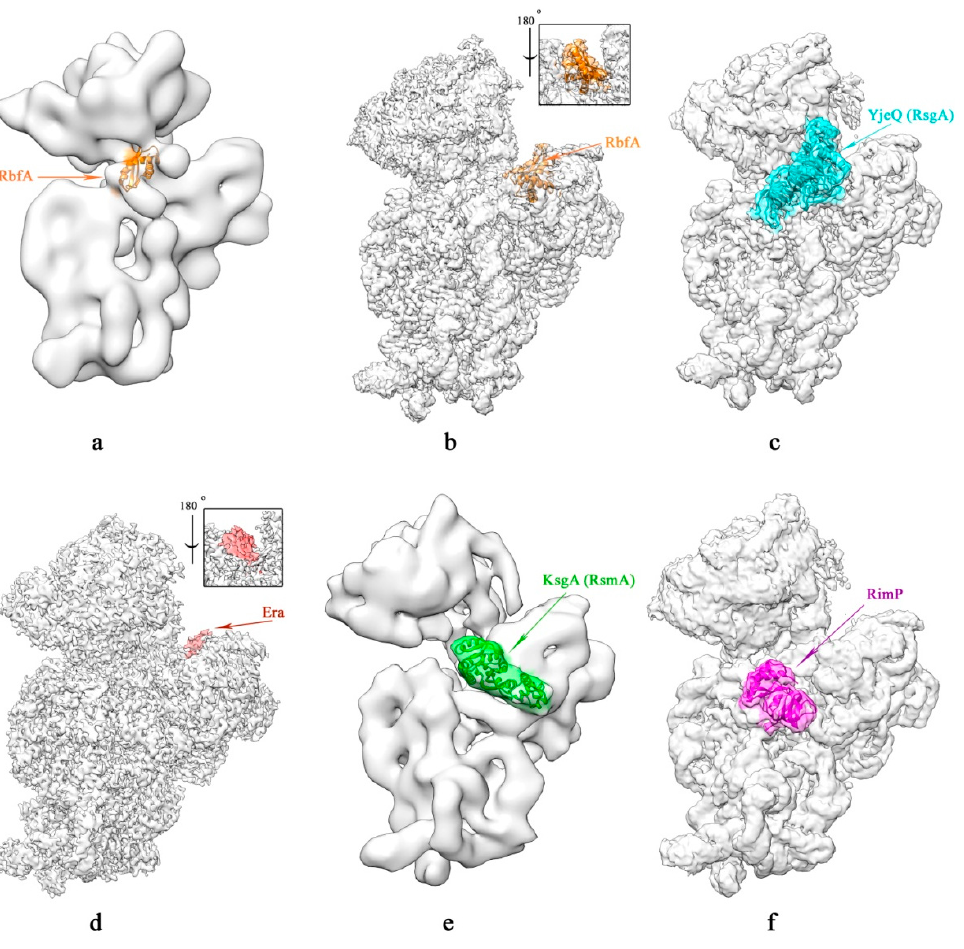
Figure 4. Cryo ‐ EM structures of 30S subunits in complex with different ribosome biogenesis factors: Figure 4. Cryo-EM structures of 30S subunits in complex with different ribosome biogenesis ( a , b ) 30S•RbfA (EMDB ID: 1413; PDB ID: 2R1C and EMDB ID: 12243; and PDB ID: 7BOH, respec ‐